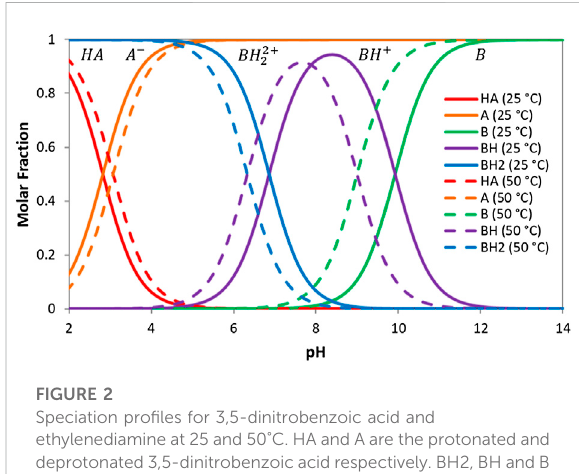
FIGURE 3 Ideal pH-solubility pro fi les for EDNB monoclinic and EDNB triclinic at 25 and 50 ° C.